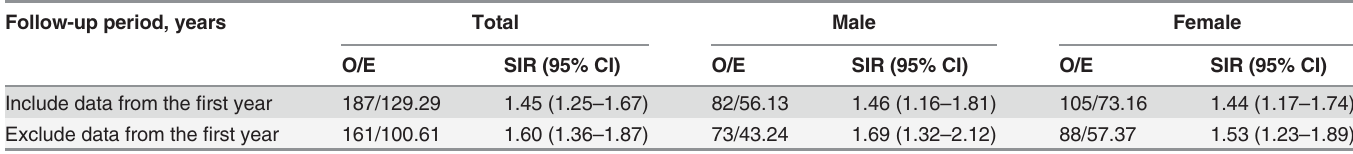
Table 3. Sensitivity analysis of the standardized incidence ratios (SIR) with 95% CI for the association between CHD and all cancer risk, with the inclusion and exclusion of data from fi rst year of follow-up. Follow-up period, years